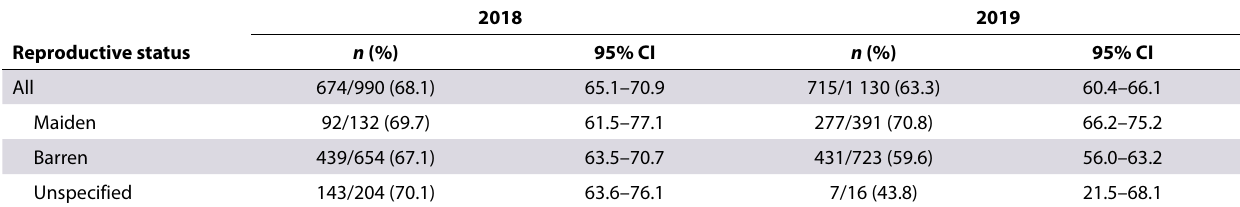
Table IV: Summary of the proportion and percentage of Thoroughbred mares by reproductive status, tested in the South African stud health scheme in 2018 and 2019, that produced a foal for